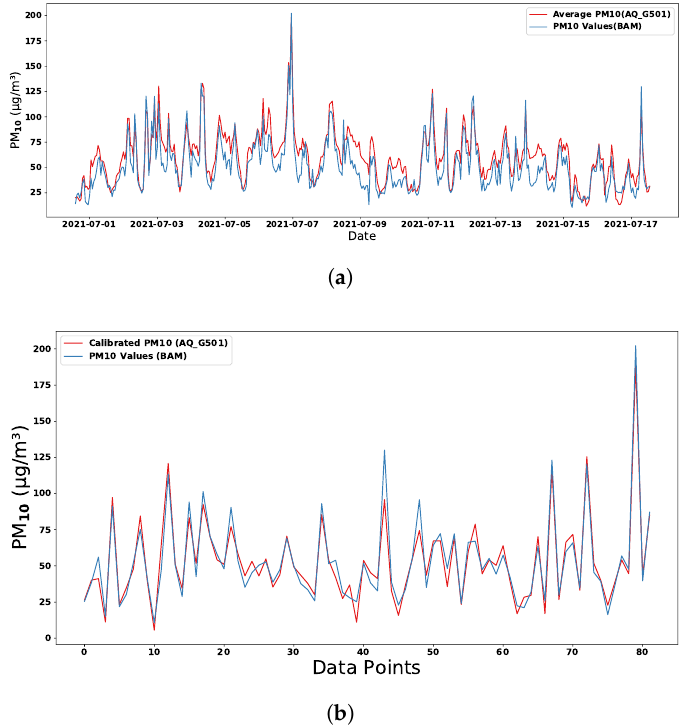
Figure 6. Calibration of PM 10 low-cost air quality sensors using machine learning methods. ( a ) In-field comparison of AirQo low-cost sensors and reference grade before calibration for PM 10 . ( b ) PM 10 Calibrated low-cost sensor data vs reference grade